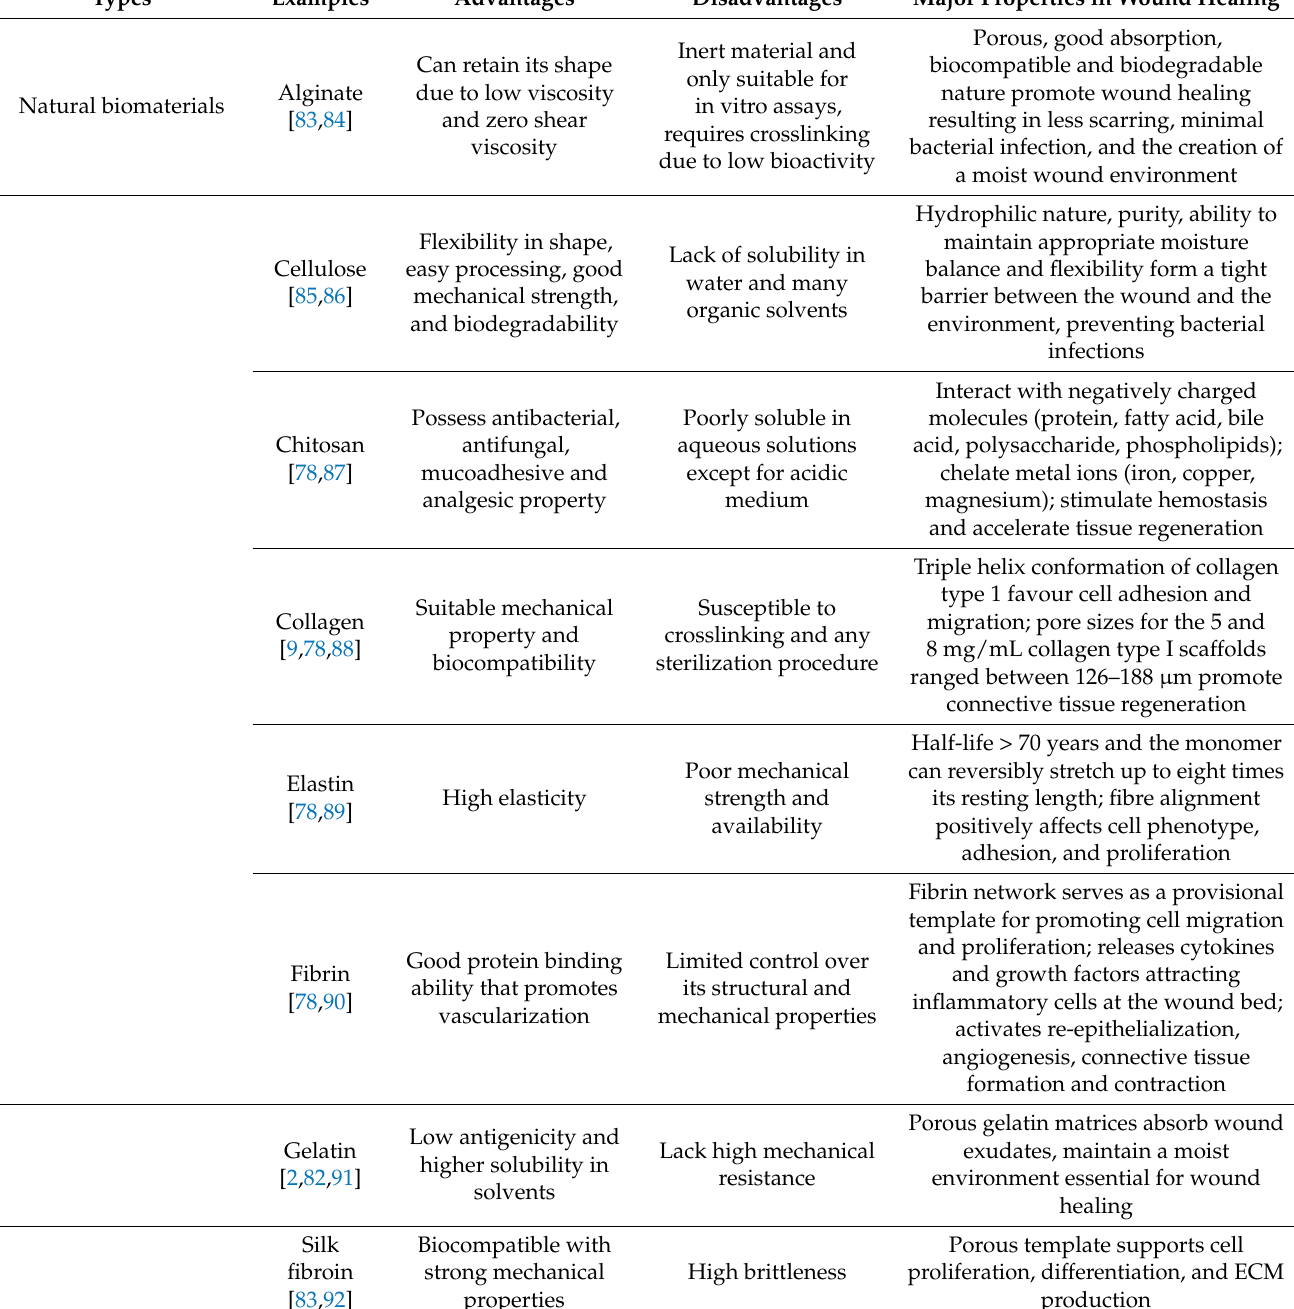
Table 4. Examples of natural and synthetic biomaterials used in skin tissue engineering along with their pros and cons.